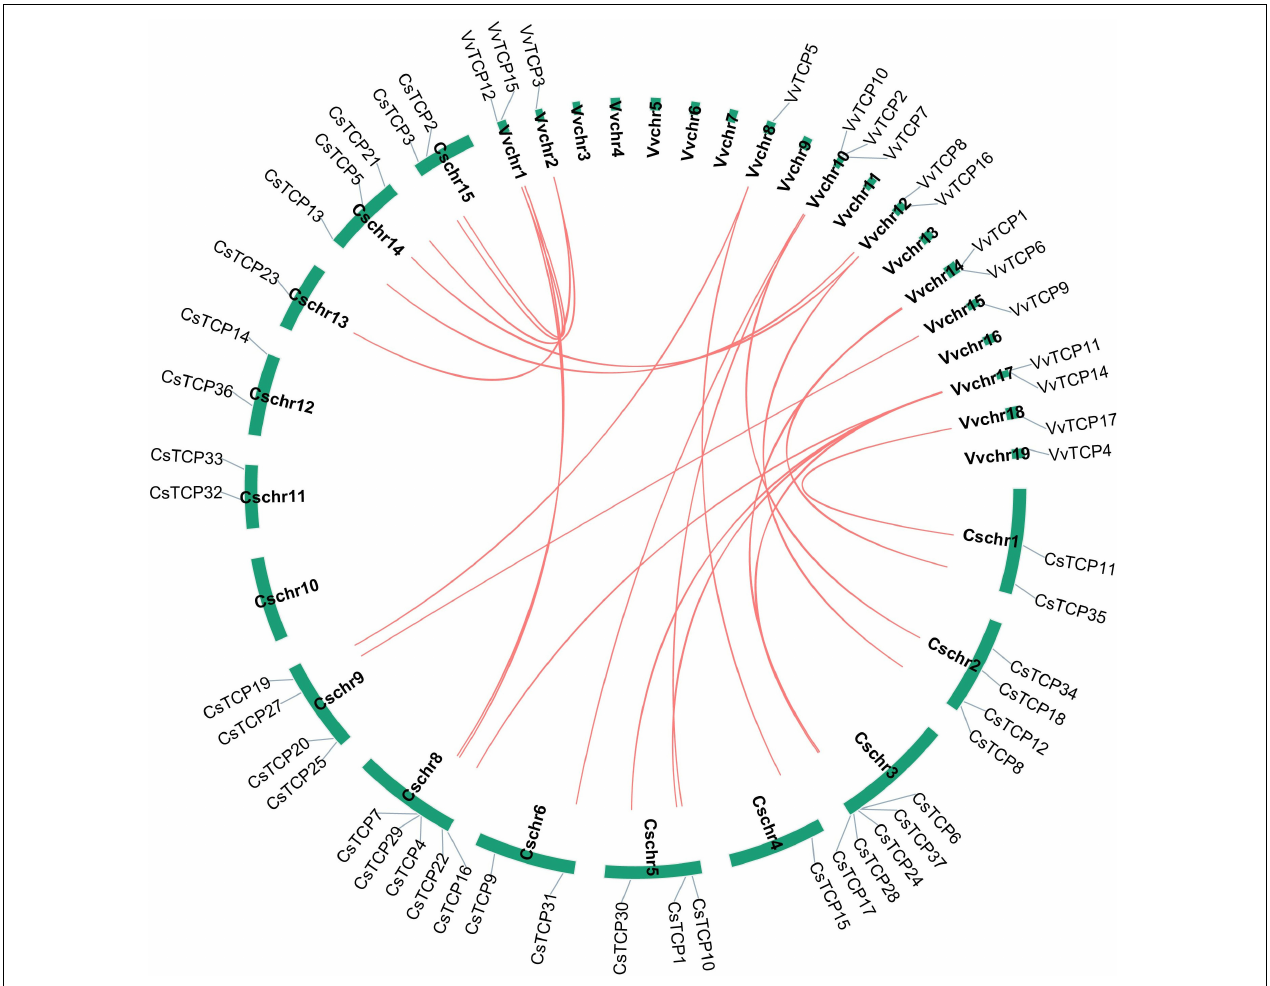
FIGURE 6 | Syntenic genes among TCP gene family between Camellia sinensis and Vitis vinifera.